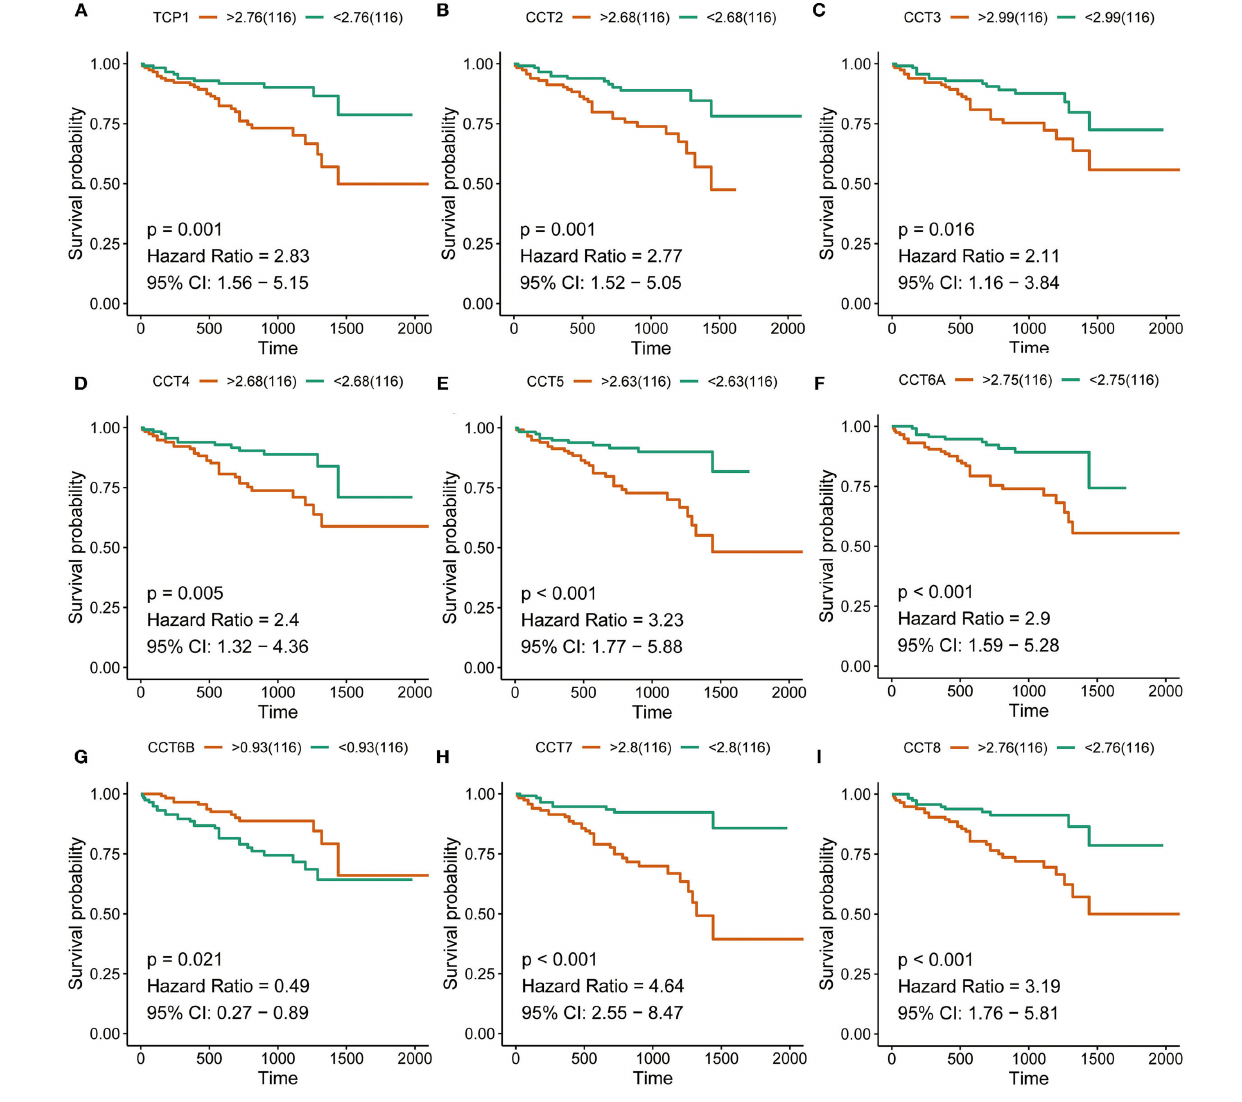
FIGURE 3 | Survival analysis of HCC patients with respect to CCT subunit gene expression. Kaplan-Meier survival analysis was performed in HCC patients from the ICGC cohort. P -value was calculated using log-rank test and is provided at the top left of each